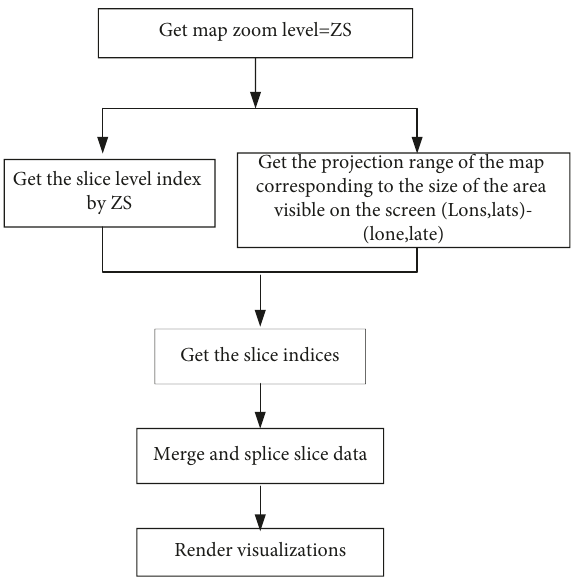
Figure 3: The rendering